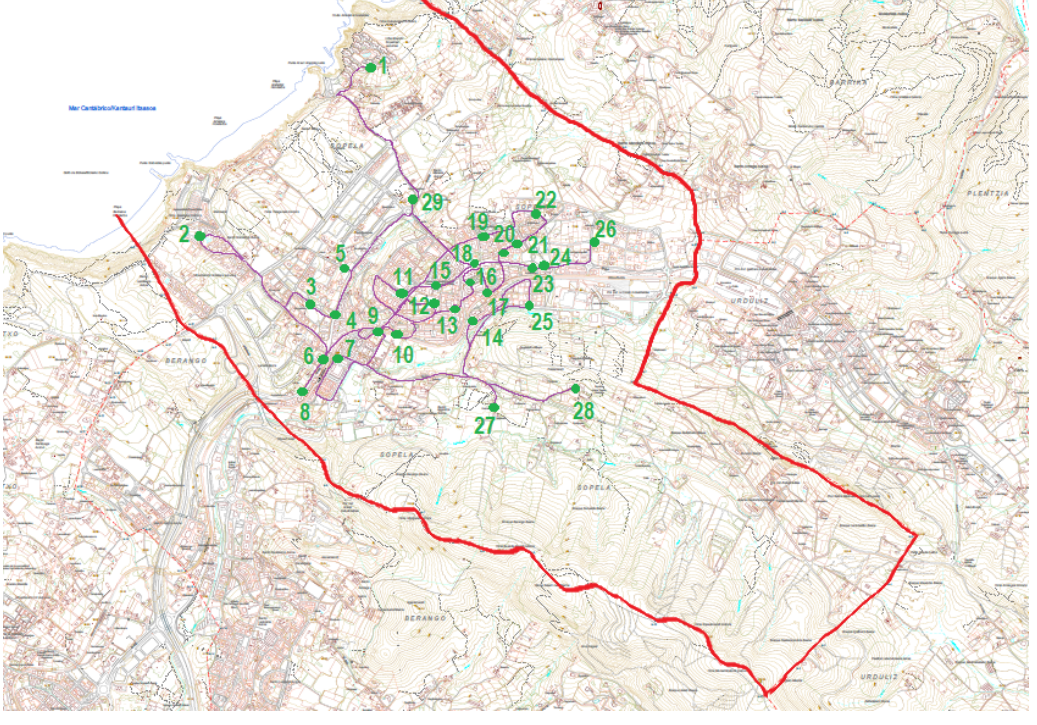
Figure 3. Actual route of problem n =